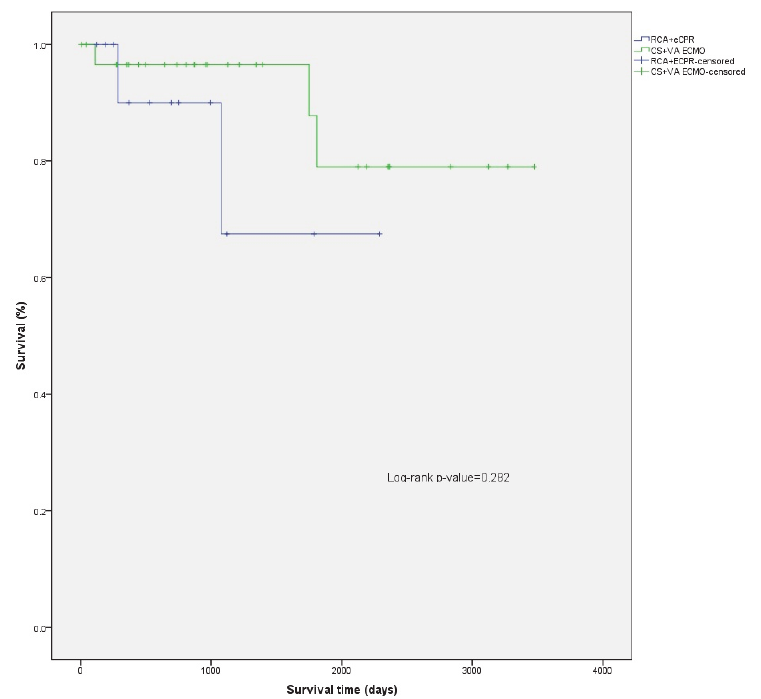
Figure 2. Comparison of survival after hospital discharge between CS and RCA patients.